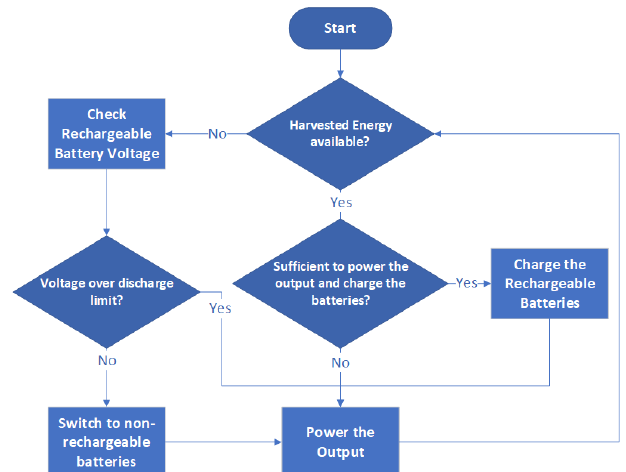
Figure 6. Flowchart that depicts the hierarchy scheme of the harvested energy over batteries and the corresponding priority of the rechargeable batteries over